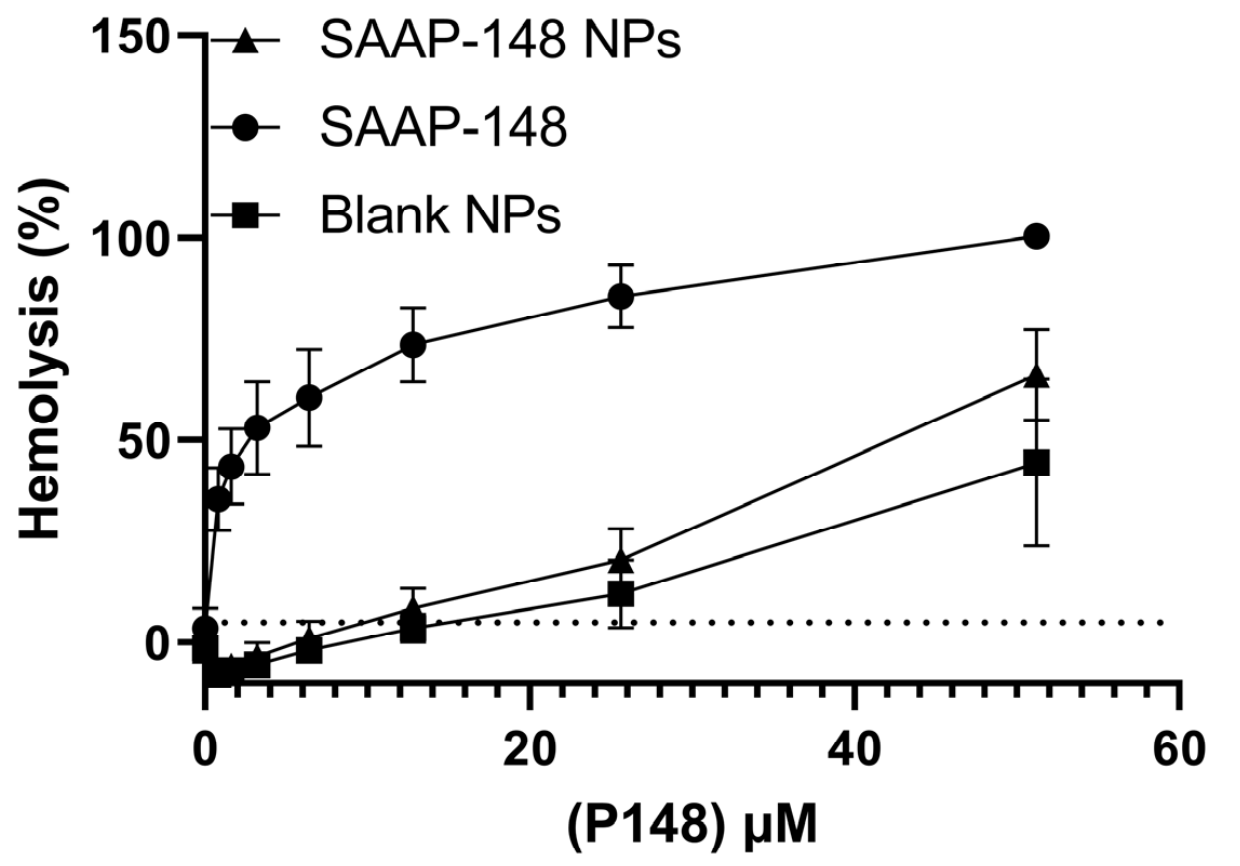
Figure 3. Hemolytic activity of SAAP-148 NPs (triangles) compared to SAAP-148 solution (circles) and blank PLGA NPs (squares) in PBS after 1 h. Hemolytic activity is based on 5% hemolysis of human erythrocytes in PBS, after 1 h incubation at 37 ◦ C, with 95% humidity and 5% CO 2 . Data retrieved from the mean of three biological replicates performed with three technical duplicates ( n = 3). Hemolytic activity is based on 5% hemolysis of human erythrocytes.